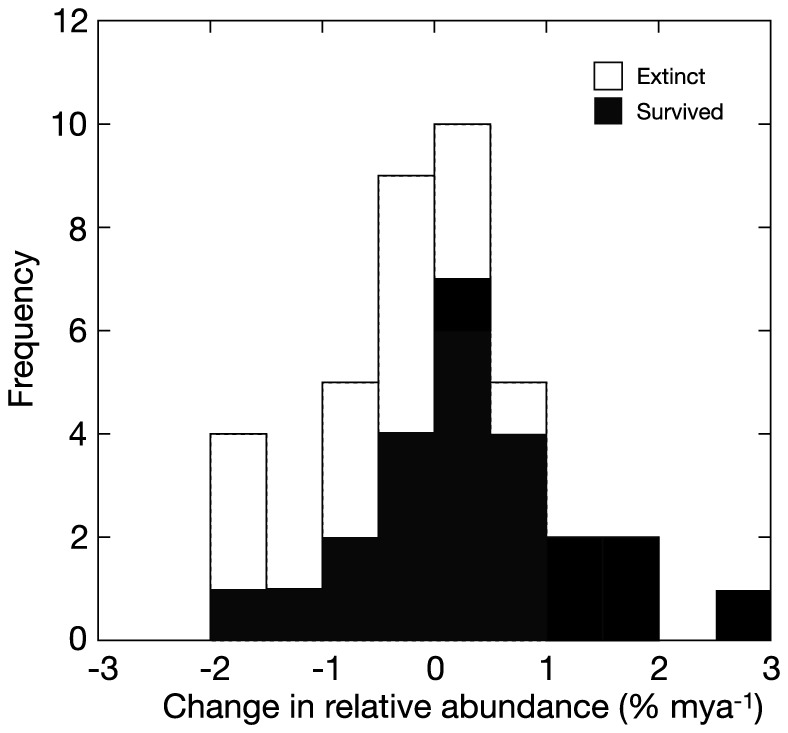
Changes in past coral communities as represented by the fossil record between 6.8 and 0.125 Ma.Changes in relative abundance of genera (% Myr−1) are shown. Histogram shows the changes in relative abundances for tropical taxa that became extinct (open bars) or survived (filled bars) in the Caribbean.